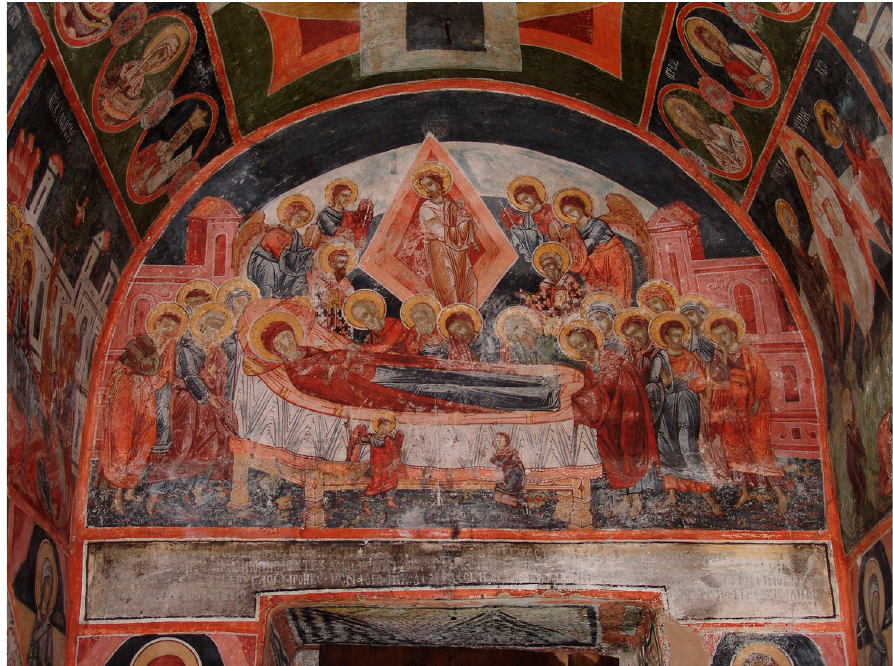
Figure 13. Dormition of the Theotokos , wall painting, 1614, Church of St. Theodore Tyron and St. Theodore Stratilates, Dobarsko, Bulgaria. (Photo credit: Ivan Vanev, The Roads of the Balkan Painters and Post-Byzantine Artistic Heritage in Bulgaria Project, http://zografi.info/, accessed on 2 February 2023).